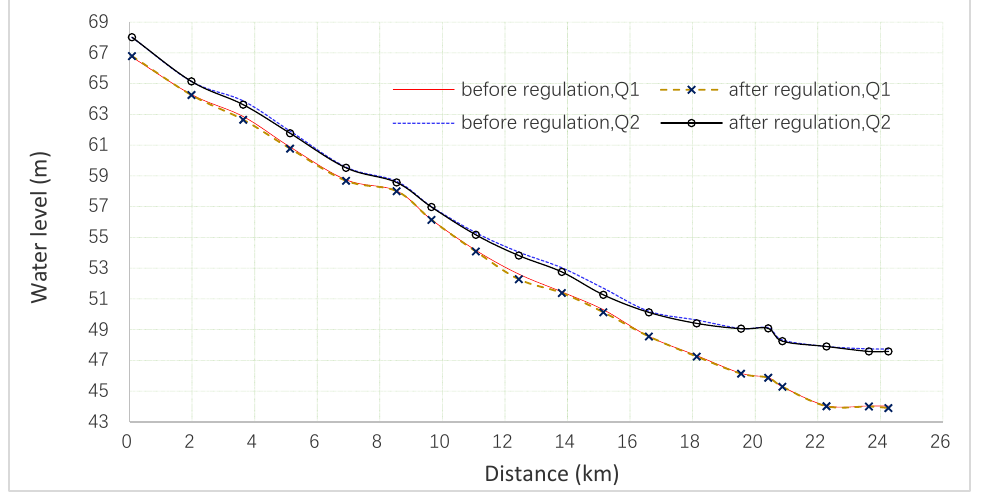
Figure 9. Comparison between Case S1 and Case S2 for the water surface along the left bank (two flood frequencies Q 1 and Q 2 ).